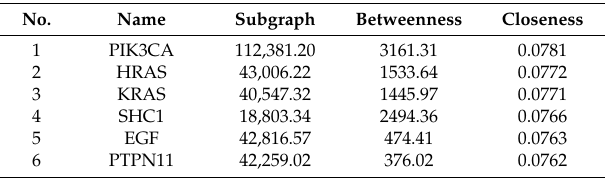
Table 3. Subgraph Centrality, Betweenness Centrality and Closeness Centrality of the nodes in the